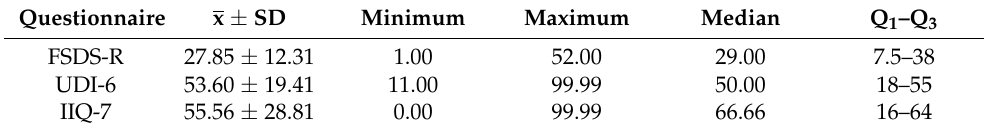
Table 3. Descriptive statistics of the results obtained from questionnaires (N = 145).